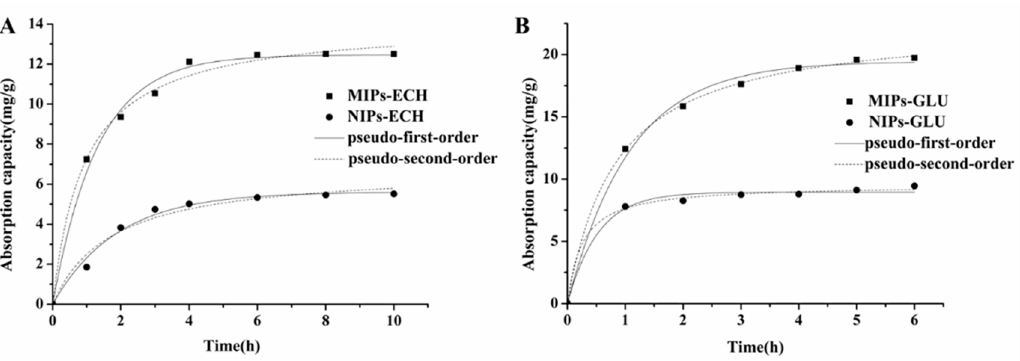
Figure 4. Adsorption kinetics of alpha-lipoic acid (ALA) on molecularly imprinted polymers (MIPs) and non-imprinted polymers (NIPs). ( A ) MIPs–ECH and NIPs–ECH, ( B ) MIPs–GLU and NIPs–GLU. Table 1. Kinetic parameters of the pseudo-first-order and pseudo-second-order equations for ALA adsorption onto the MIPs and NIPs adsorbents. Pseudo-First-Order Polymers Q e (mg/g)